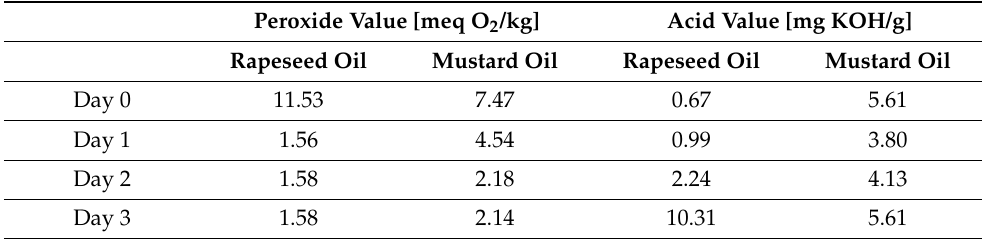
Table 2. Acid [mg KOH/g] and peroxide values [meq O 2 /kg] of rapeseed and mustard oils. Peroxide Value [meq O 2